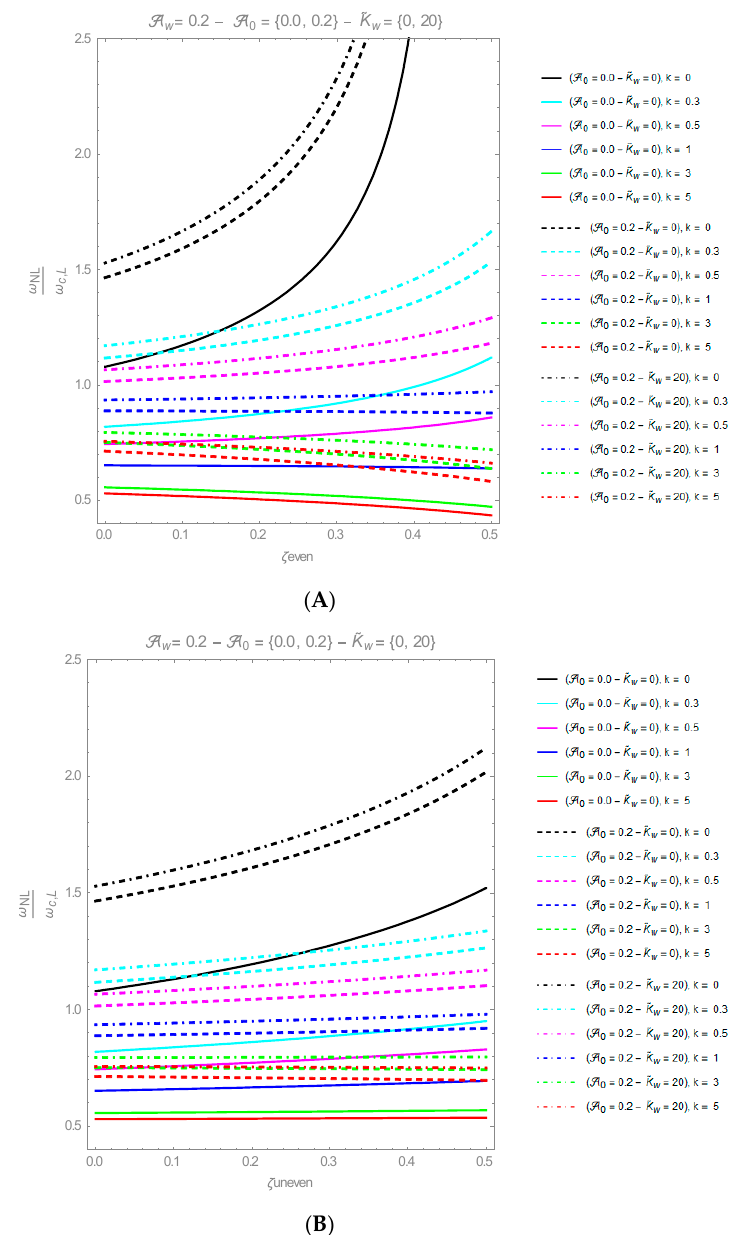
Figure 9. Simply-supported porous FG nano-beams. Frequency ratio versus porosity volume fraction with k ranging in the set {0, 0.3, 0.5, 1, 3, 5} and (cid:101) K w varying in the set {0, 20}: ( A ) even distribution of porosity and ( B ) uneven distribution of porosity.